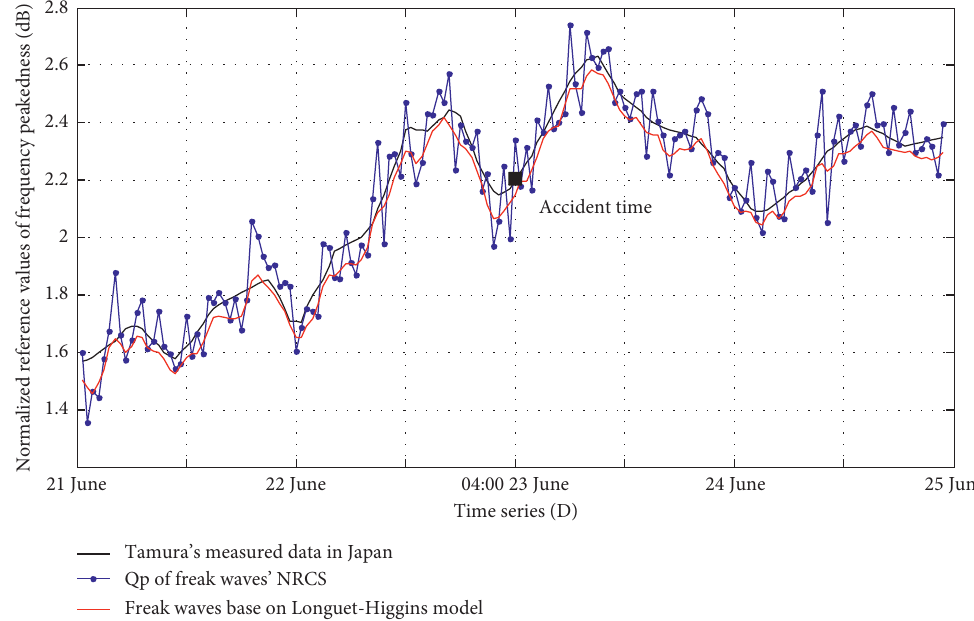
Figure 13: Comparison of spectral peakedness of Longuet-Higgins simulation result and freak wave measured in Tokai,